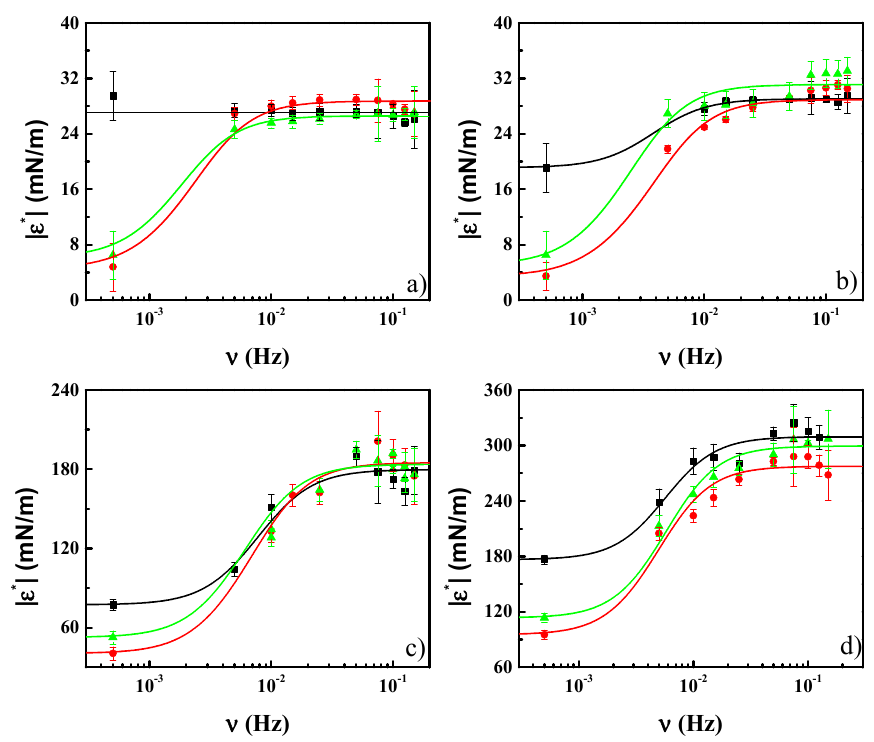
Figure 7. Experimental (symbols) and calculated, using Equation (7), (lines) dependences of the interfacial dilational viscoelasticity modulus on frequency at di ff erent values of the surface pressure Π : ( a ) 3 mN / m, ( b ) 7.5 mN / m, ( c ) 20 mN / m, and ( d ) 40 mN / m. In the plots, each set of data corresponds to a di ff erent value of x CN : ( (cid:4) , — ) 0, ( (cid:8) , — ) 0.26 mN / m and ( (cid:78) , — ) 0.42.